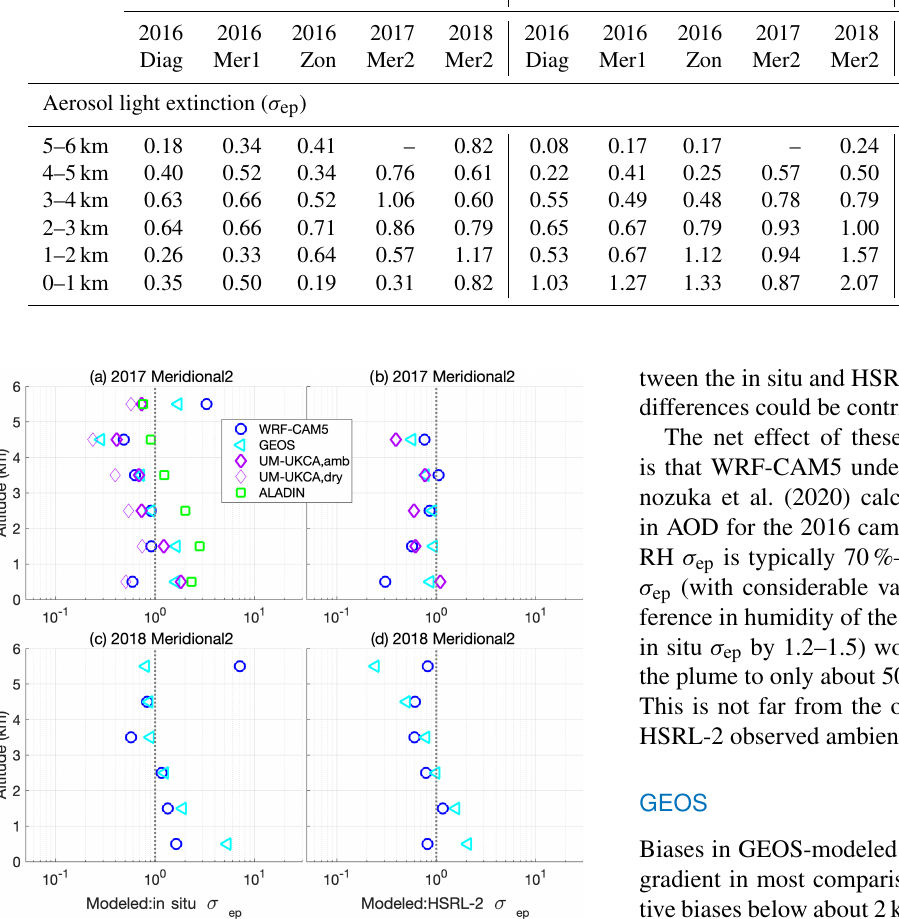
Figure 15. As in Fig. 14 but for the (a, b) 2017 and (c, d) 2018 meridional 2 comparison transects. The ratios for individual grid boxes, along with these means, are given in the Supplement (Fig. S16 for WRF-CAM5, Fig. S18 for GEOS, Fig. S20 for UM- UKCA, and Fig. S21 for